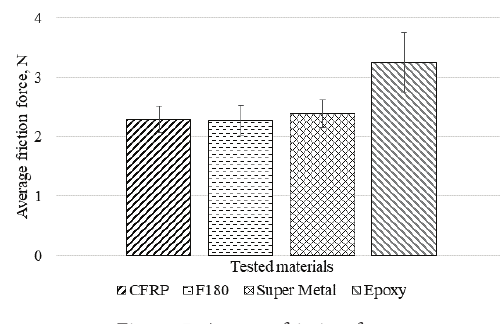
Figure 5. Average friction force